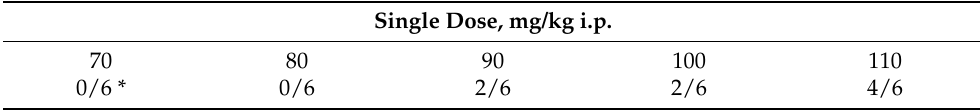
Table 5. Drug-induced lethality in Balb/c mice injected with complex 16 . Single Dose, mg/kg